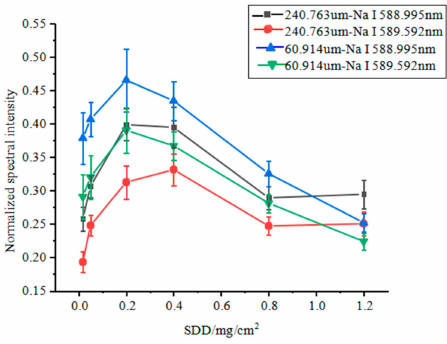
Figure 11. Changes in the spectral intensities of Na in NaCl samples di ff ering in particle size with NaCl concentration.